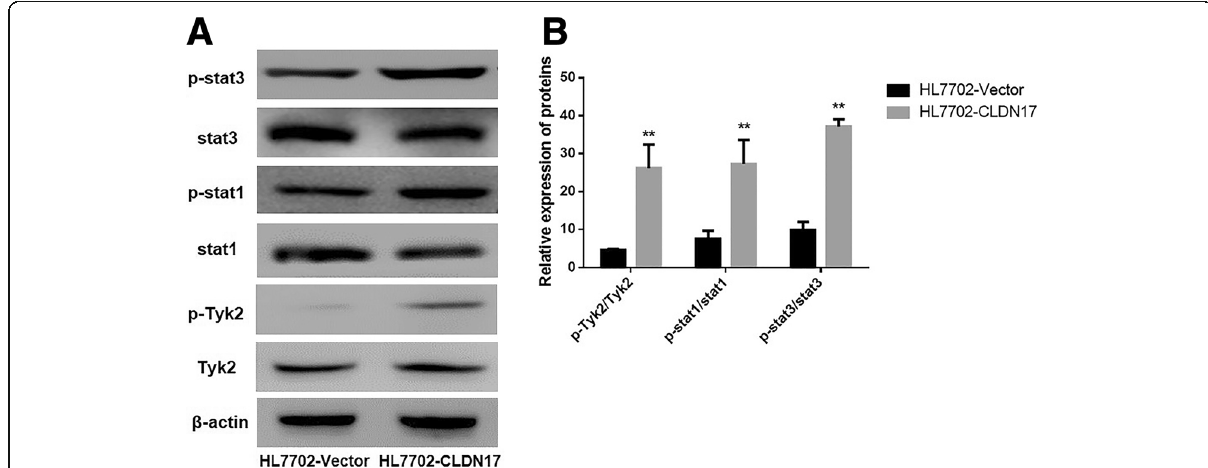
Fig. 4 The impact of CLDN17 on the Tyk2/Stat3 signaling pathway. a Western blotting was utilized to detect the activation of the Stat3 signaling pathway in the HL7702 cell line; ( b ) The corresponding statistical analysis of the activation status of various Stat3 pathway components. Note: * represents P < 0.05 and ** represents P < 0.01 compared with the empty vector